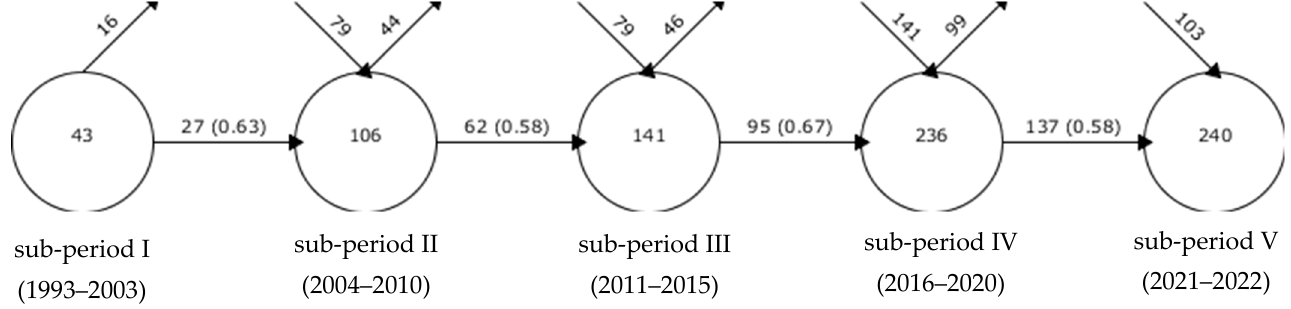
Figure 10. The overlay graph.